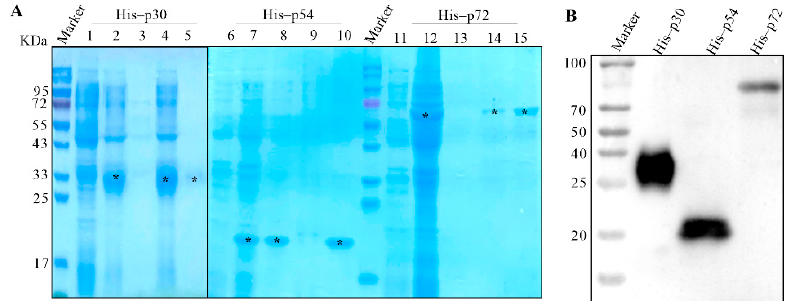
Figure 2. Identification of His–fused p30, p54 and p72 proteins. ( A ) Identification of purification of His–fused p30, p54 and p72 proteins by SDS–PAGE. All the samples were electrophoresed on SDS–PAGE and visualized by coomassie brilliant blue G250 staining. Here, 1, 6, 11 represent whole cell lysates without IPTG induction, 2, 7, 12 represent whole cell lysates with IPTG induction, 3, 8, 13 represent the expression of His–fused protein from the supernatant, 4, 9, 14 represent the expression of His–fused protein from the inclusion bodies and 5, 10, 15 represent purified proteins. ( B ) Western blot identification of the His–fused p30, p54 and p72 proteins. The purified His–fused p30, p54 and p72 proteins were separated by SDS–PAGE and transferred to PVDF membrane. The target proteins were probed with anti–His antibody. *: the target bands.